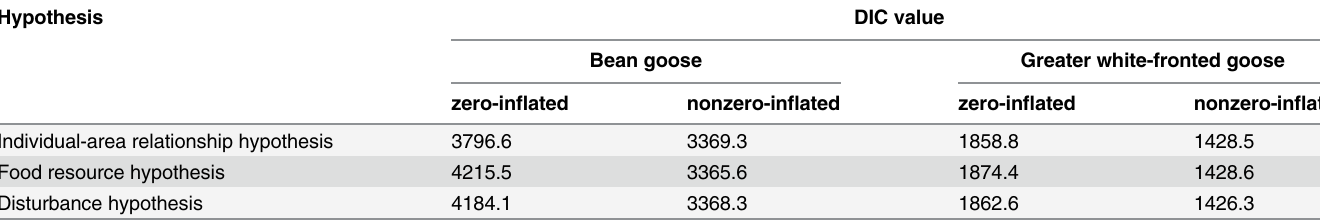
Table 2. Comparison of the values for the deviance information criterion (DIC) between models (MCMCglmm) that were built using a zero-inflated (zipoisson) and nonzero-inflated (poisson) distribution.